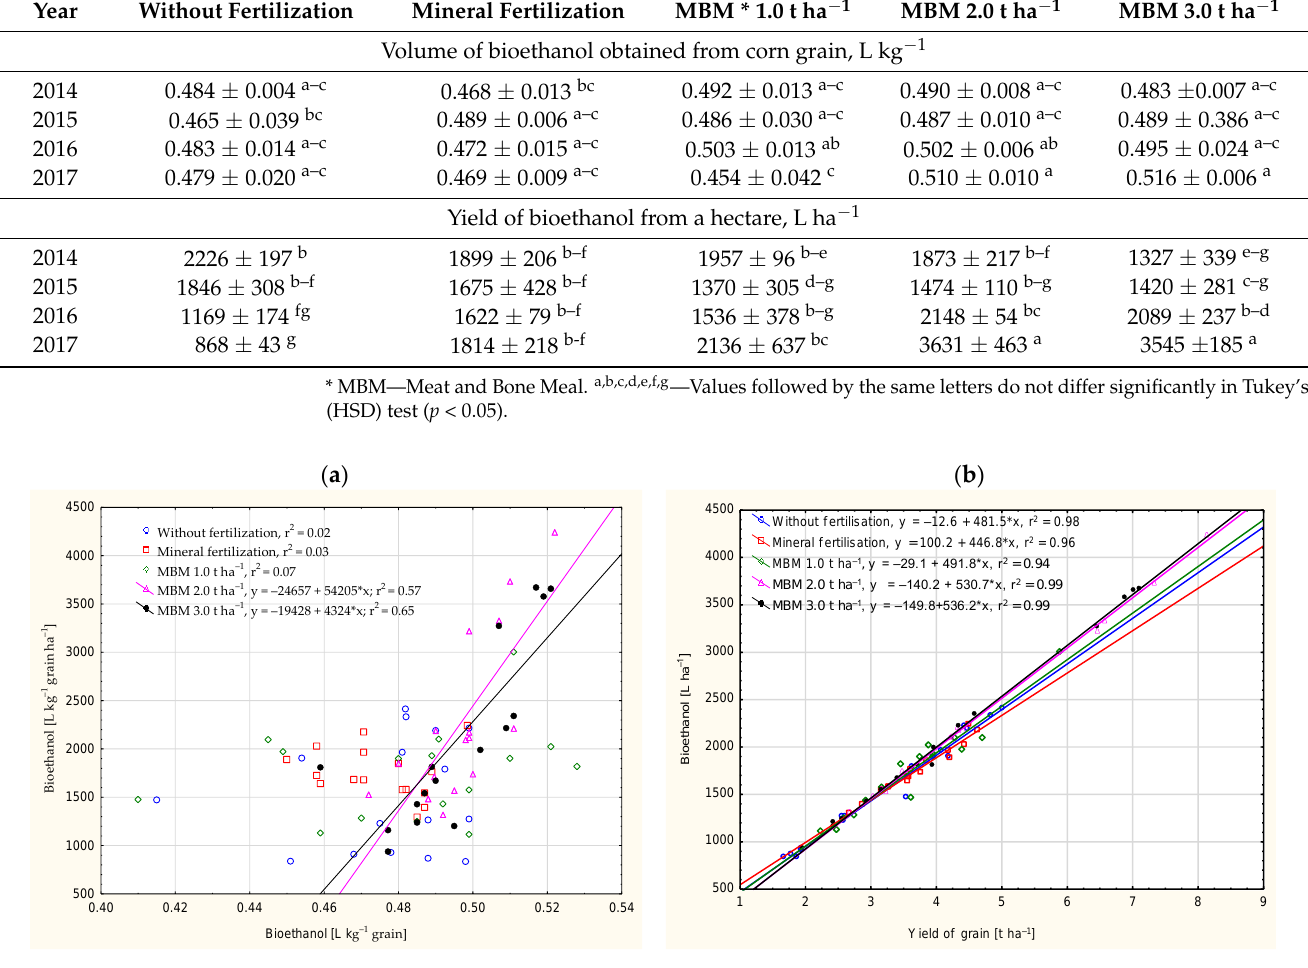
− 1 of grain ( a ) and grain